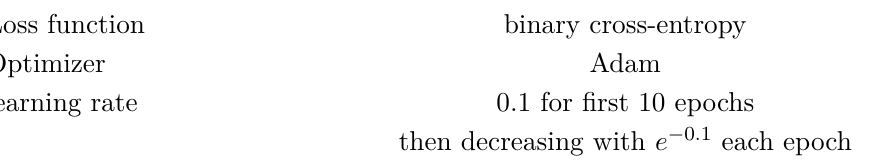
Table 1 . Neural network architecture.